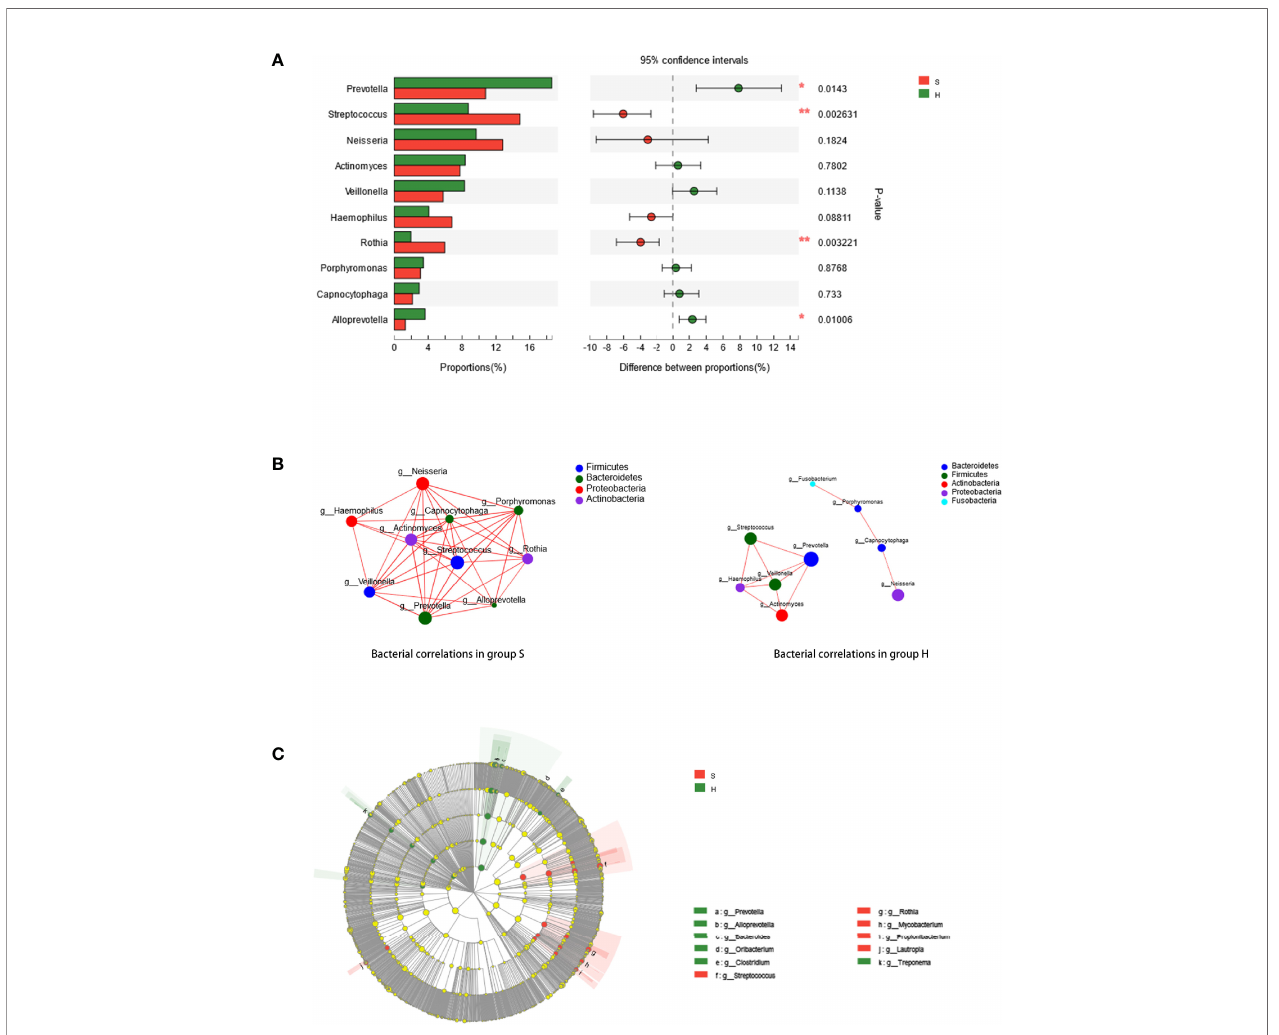
FIGURE 3 | (A) Wilcoxon rank-sum test bar plot. Relative abundances of the ten most prevalent genera are compared between group S and (H) * represents a signi fi cant difference (P < 0.05) and ** represents a highly signi fi cant difference (P < 0.01). (B) Correlations of prevalent genera. Ten richest genera were shown by co- occurrence analysis. The size of the node is proportional to the genera abundance. Node color corresponds to phylum taxonomic classi fi cation. (C) Potential biomarkers de fi ned by LEfSe. Cladogram for taxonomic representation of signi fi cant differences between group S and H were shown. The colored nodes from the inner to the outer circles represent taxa from the phylum to genus level. The signi fi cantly different bacteria are signi fi ed by different colors representing the two